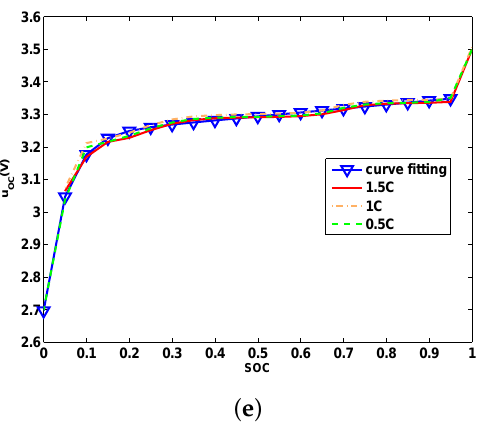
Figure 7. U oc against SOC for the lithium-ion batteries. ( a ) discharging current of Figure 4a; ( b ) discharging current of Figure 4c; ( c ) discharging current of Figure 4e; ( d ) the average value curves for u oc -SOC at temperature − 10 ◦ C, 0 ◦ C, 10 ◦ C and 25 ◦ C; ( e ) the fitting curve for the three average value curves of ( d ).